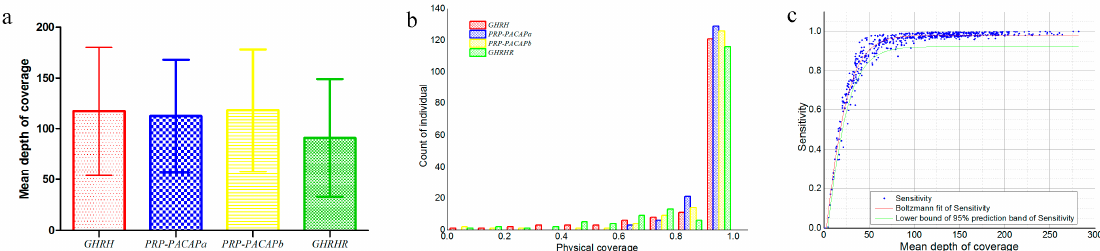
Figure 1. Illustration of the structure of the candidate genes. Fragments of the growth hormone-releasing hormone (GHRH) and PACAP-related peptide/pituitary adenylate cyclase activating polypeptide a (PRP-PACAPa) and b (PRP-PACAPb) genes included entire genes, and fragment from the GHRH receptor (GHRHR) gene is denoted by a pink line. Sequences of these four fragments were submitted to NCBI, and accession numbers were KR269823.1, KR269822.1, KR269834.1 and KR269832.1, respectively.